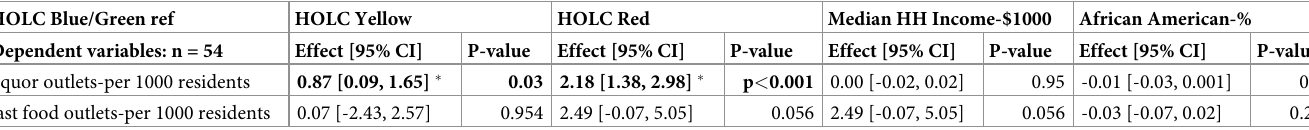
� Significant at the 95% confidence level. Unit of analysis is the community statistical area. Dependent variables in columns, independent variables and covariates in rows. Mean and 95% CI reported. CSA neighborhood factors are individually regressed on HOLC yellow and HOLC red vs. blue/green, with covariates of neighborhood median household income, proportion of African American residents. Effects are reported as additional outlets per 1000 residents for the relevant HOLC grade (yellow or red) as compared to the reference category of HOLC blue/green. Median household income and percent African American are controls and effects should not be interpreted